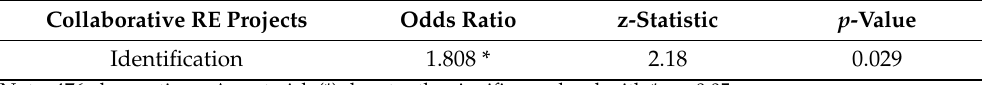
Table 4. Logistic regression: endorsement of collaborative renewable energy projects. Collaborative RE Projects Odds Ratio z-Statistic p -Value Identification 1.808